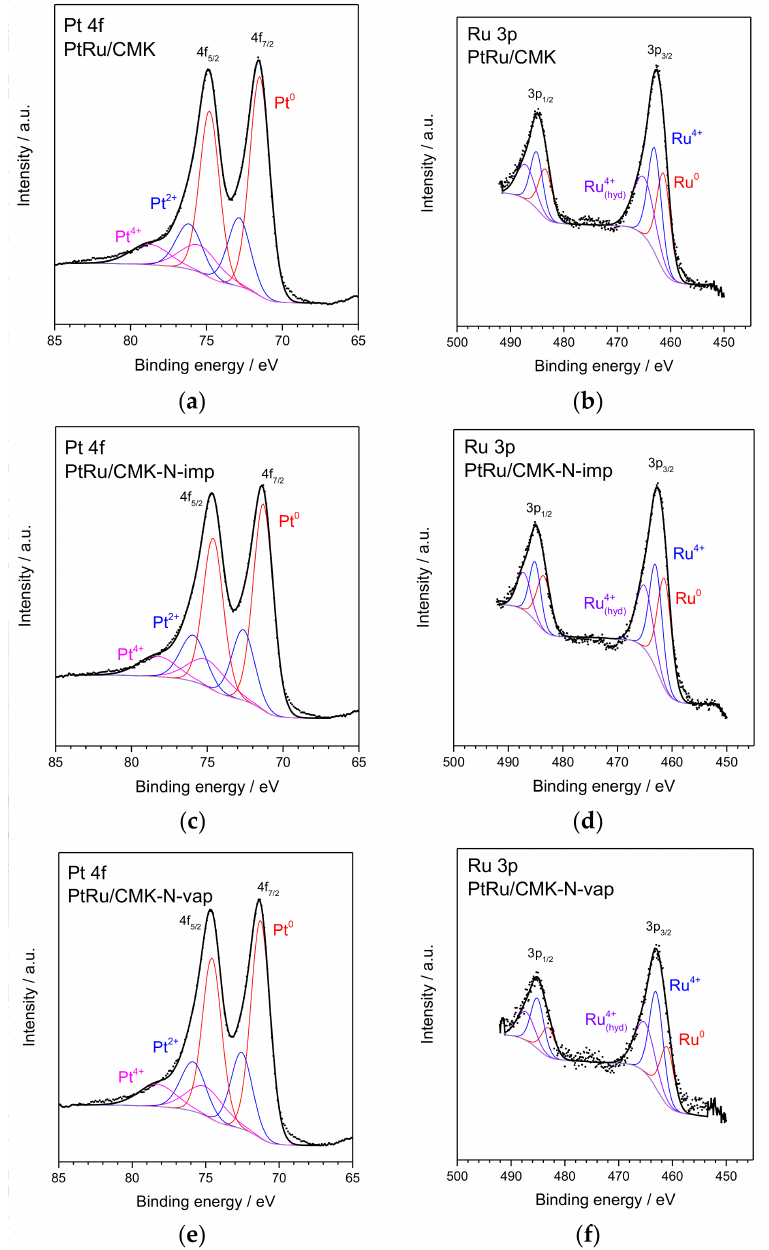
Figure 5. XPS high-resolution spectra of Pt 4f (left) and Ru 3p (right) for: ( a , b ) PtRu/CMK; ( c , d ) PtRu/CMK-N-imp; ( e , f )